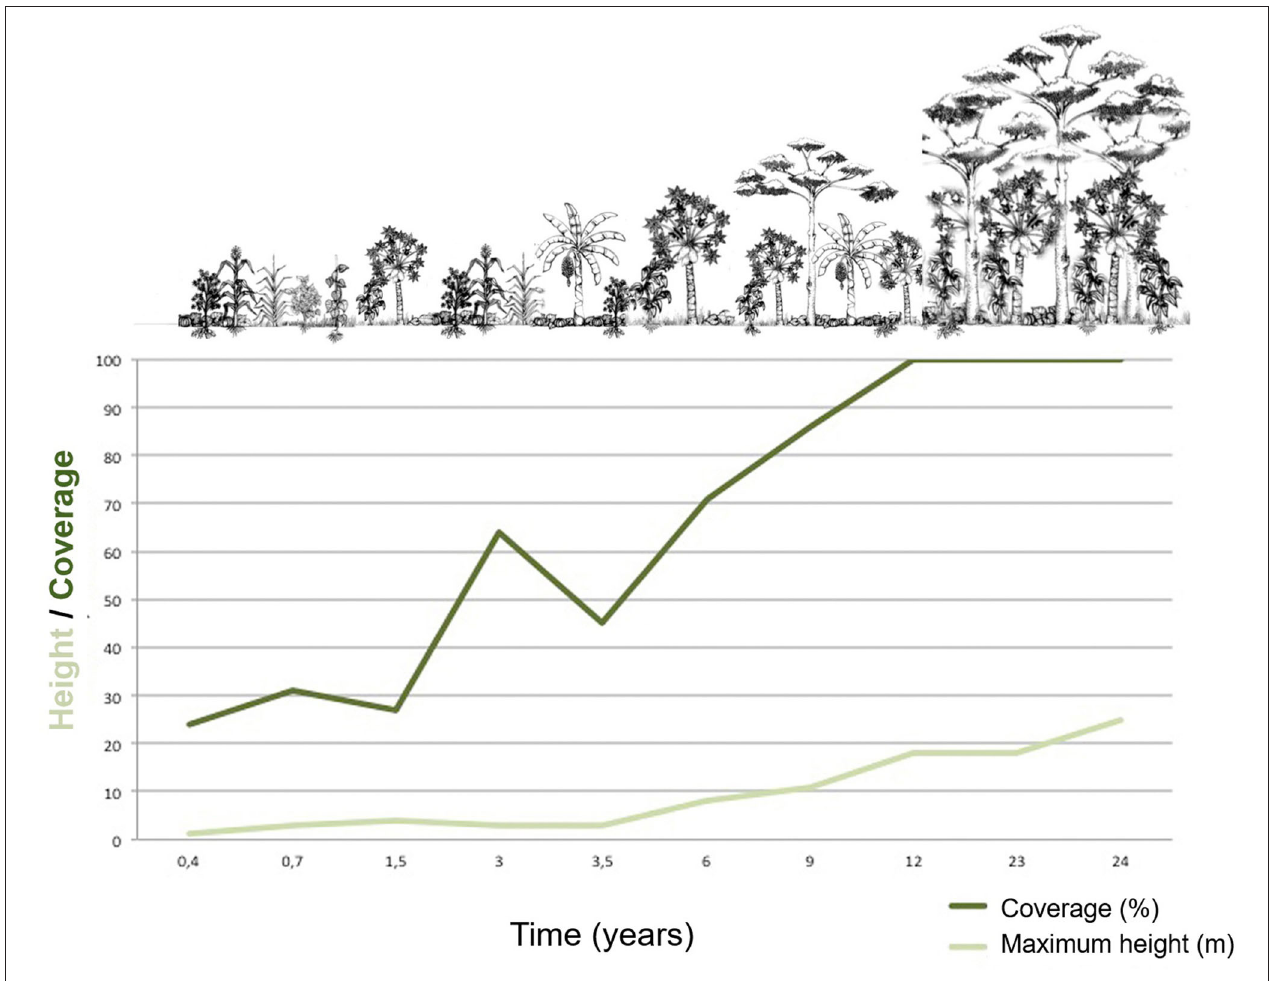
FIGURE 1 | Piaroa Conuco temporal evolution: Ground cover and vegetation maximum height. Information gathered from Freire (2002), Villarreal et al., 2003, Bonilla-Bedoya et al. (2012), Ricardo et al.